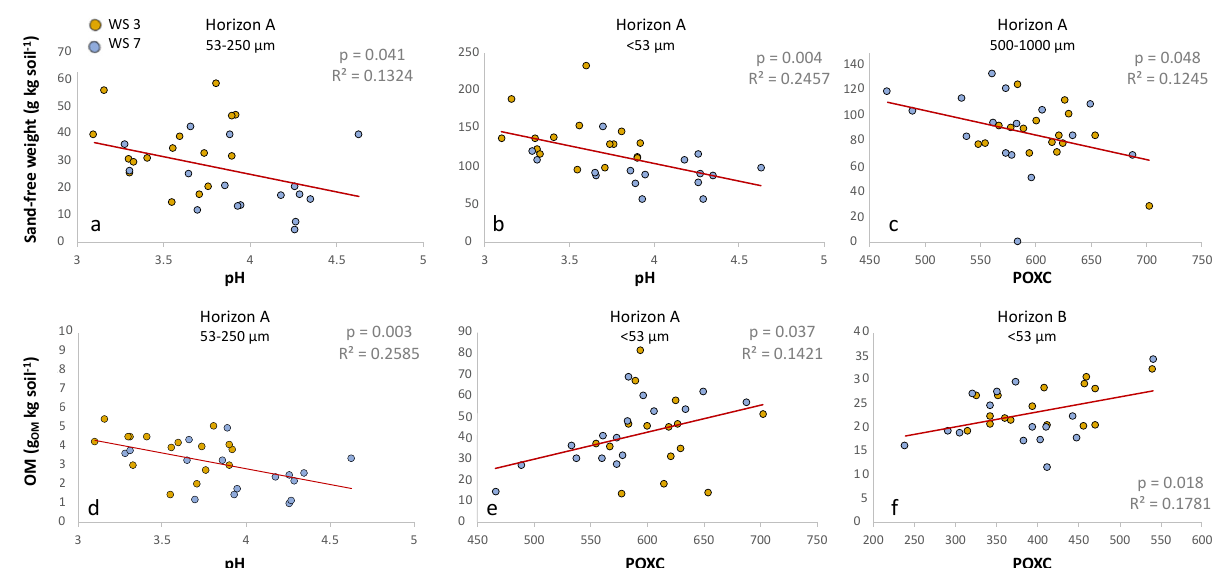
Figure 5. Significant relationships between ( a , b , d ) soil pH CaCl2 with micro-aggregate size fractions weight and OM, and ( c , e , f ) POXC (g POXC kg soil − 1 ) with aggregate size fractions weight and OM: colored dots refer to data within a watershed. R 2 and p -values are denoted for each panel for all data across watersheds.